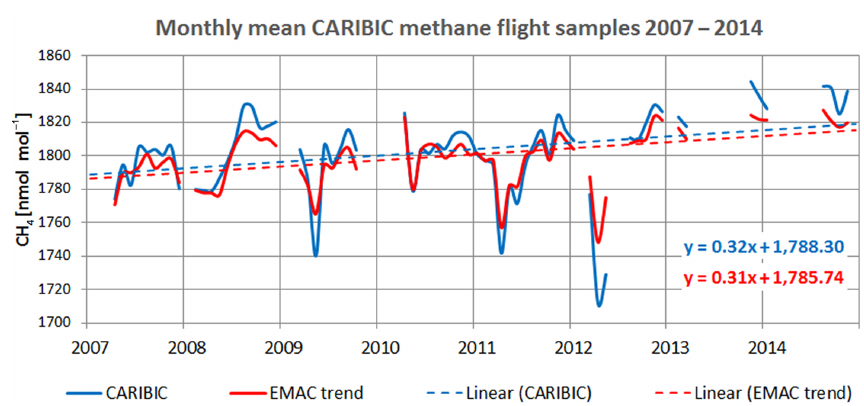
Figure 13. Monthly averaged EMAC-CH 4 , including trend and CARIBIC-2 observations from 2007 to 2014 for all data obtained from CARIBIC whole air samples (WASs) in blue, and model results in red.